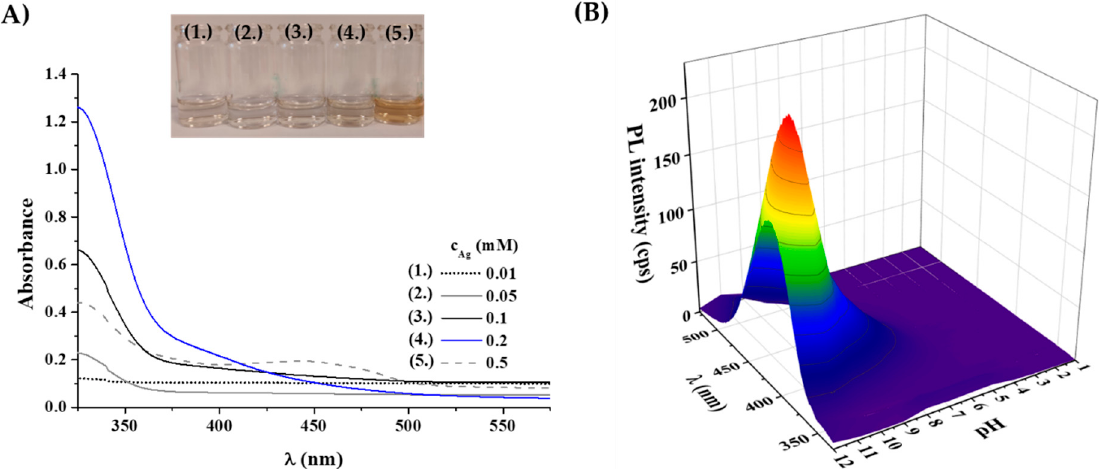
Figure 1. ( A ) UV-Vis spectra and photos of the prepared Tyr-Ag samples depending on the applied metal content. ( B ) Measured fluorescence spectra of the samples after 24 h synthesis time at 80 °C as a function of the applied initial pH of the reaction mixture ( λ ex = 320 nm; c Ag = 0.2 mM; c Tyr = 1 mM).